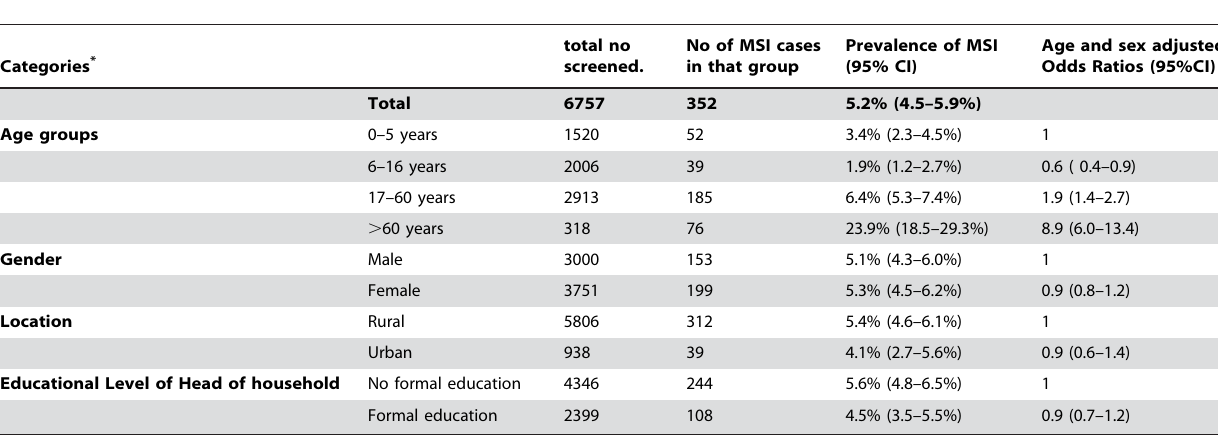
Table 2. Prevalence of MSI by age, gender, location and educational level of head of household.